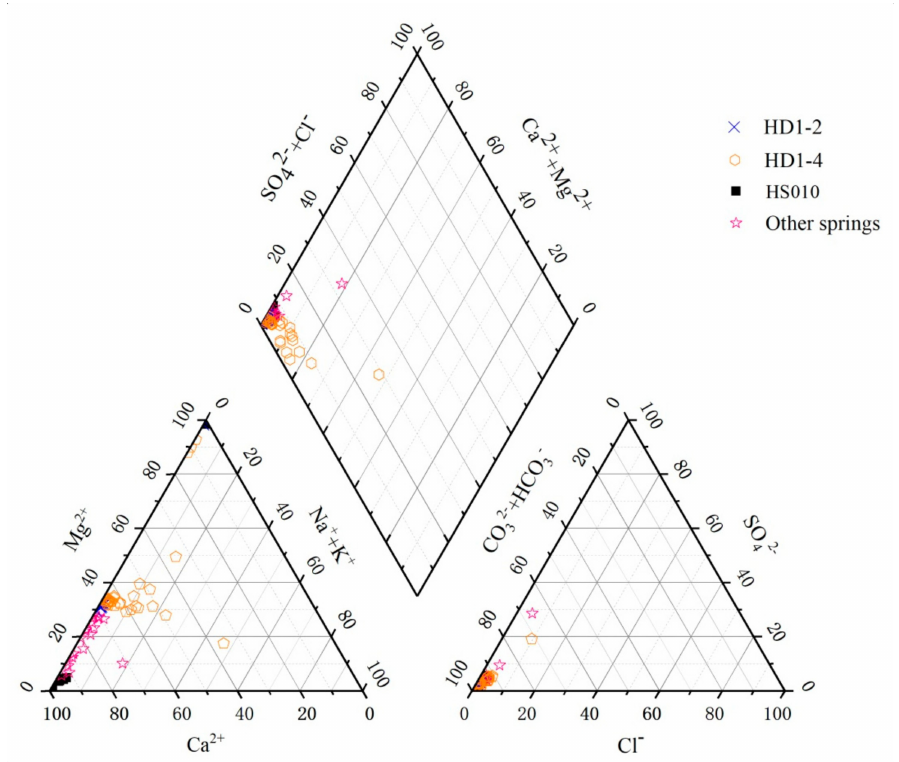
Figure 5. Water chemistry type division map.